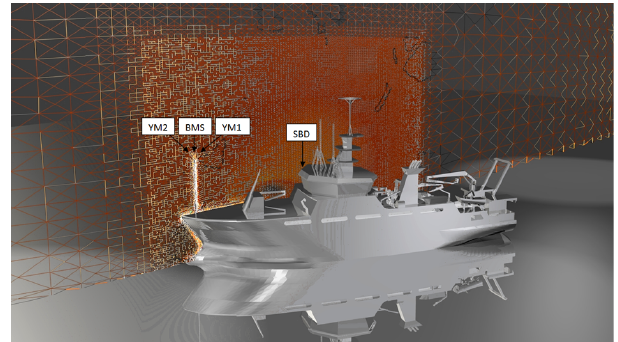
Fig. 3. RV Celtic Explorer model with cross section of hex mesh and relative position of experimental anemometers – bow-mast Gill sonic (BMS), Young’s mean 1 (YM1), Young’s mean 2 (YM2) and ship bridge deck